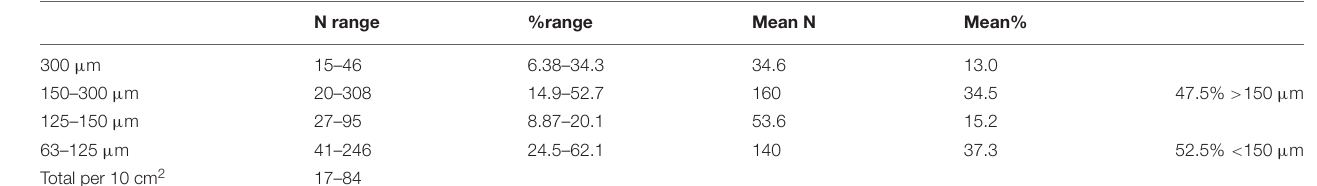
TABLE 2 | Numbers and percentages of fragmentary foraminiferal tests (stained + dead) in the 5 sample splits of which the > 150 µ m and 63–150 µ m fractions were analyzed. N